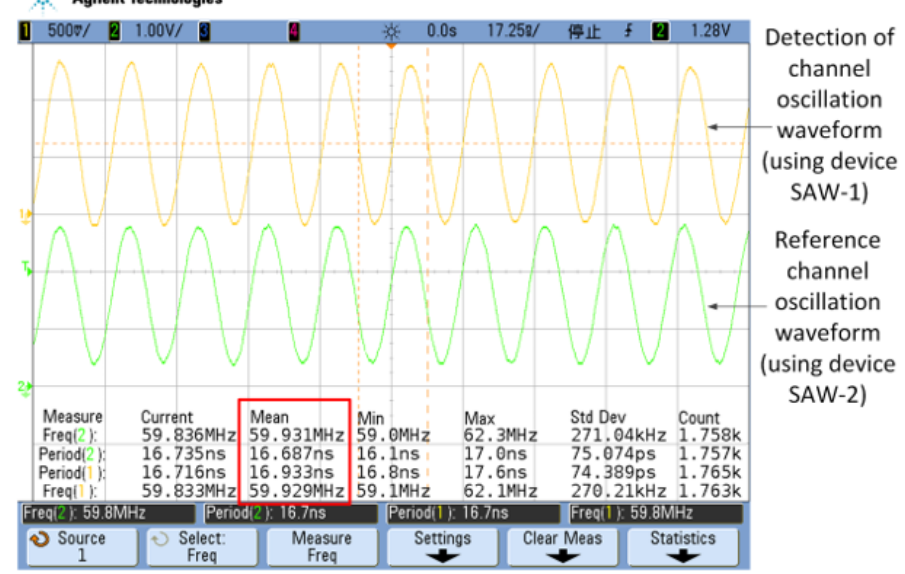
Figure 7. Surface acoustic wave oscillator waveform diagram (Test by KEYSIGHT 4000X) . When the environment temperature changes, the frequency of the output signal of surface SAWO2 is: